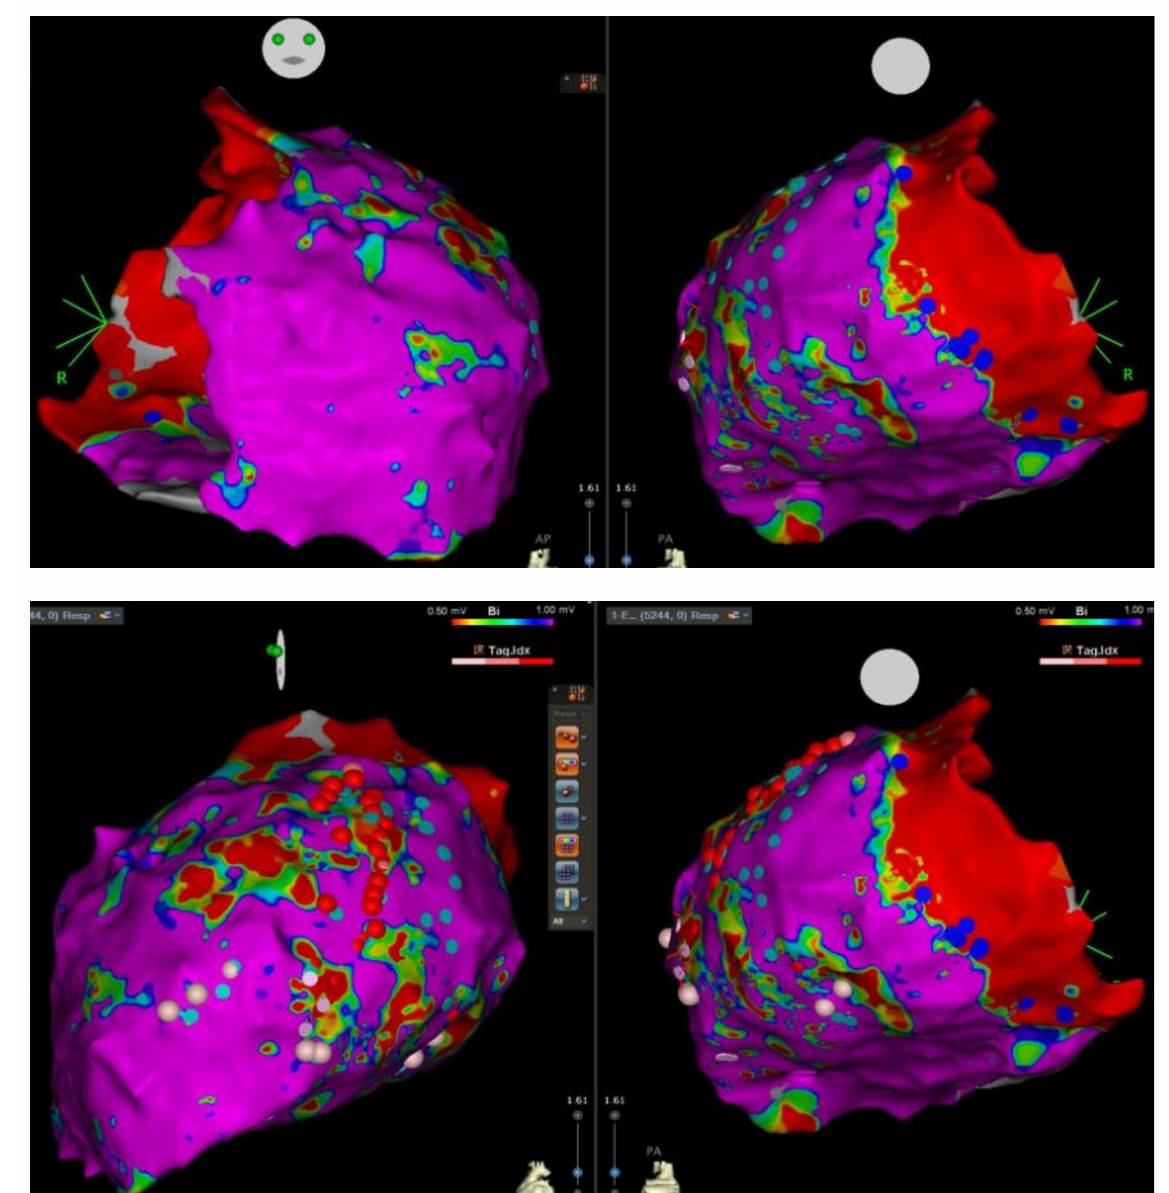
Figure 5. Epicardial high-density CARTO ® voltage map. The lower panels show multiple ablation points (red and pink